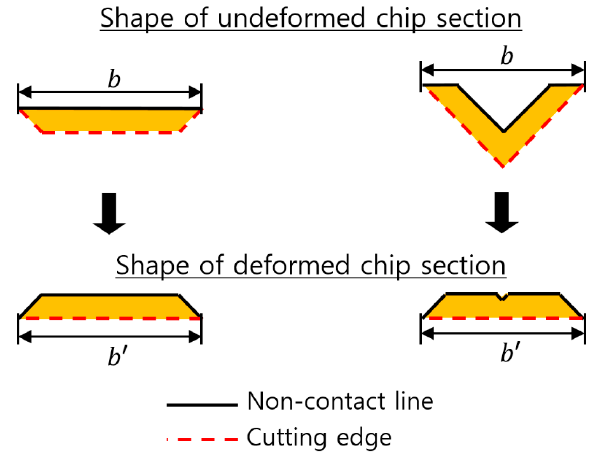
Figure 12. Illustration of chip deformation. ( b : undeformed chip width, b’ : deformed chip width).